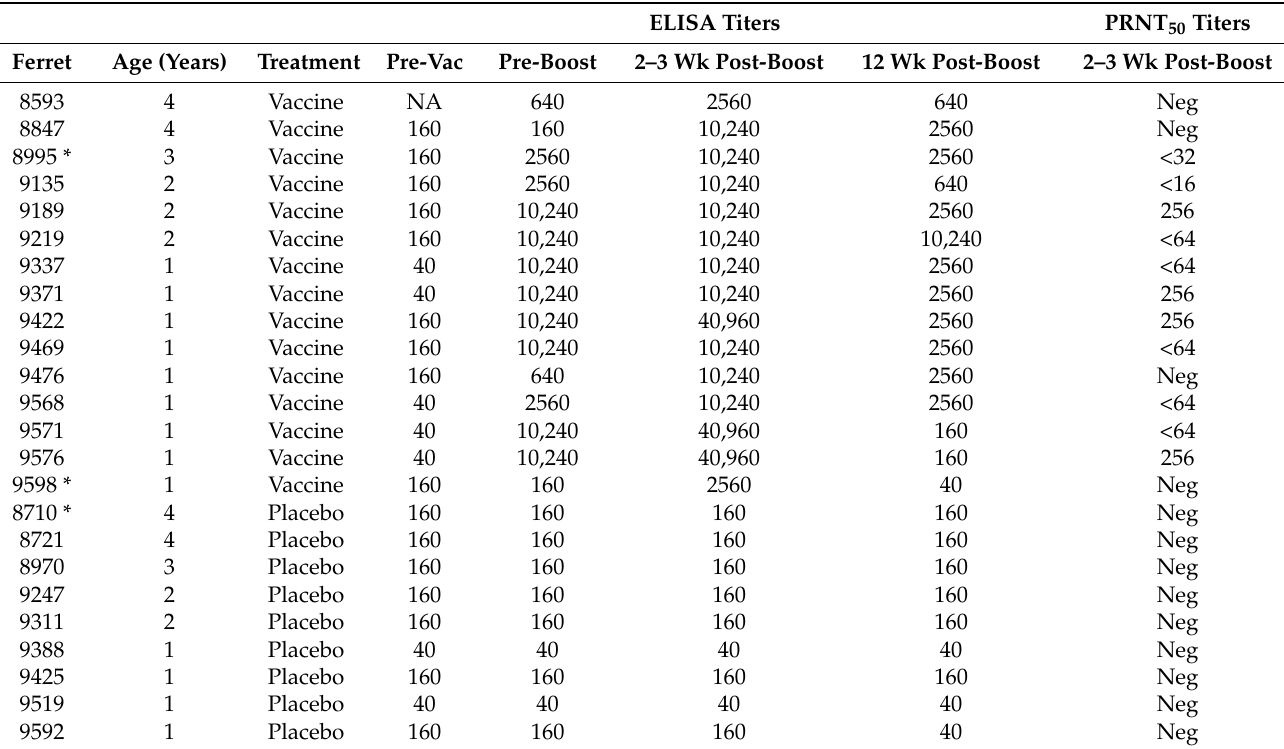
Table 1. Anti-SARS-CoV-2 antibody titers in black-footed ferrets determined by enzyme linked immunosorbent assays (ELISA) and plaque reduction neutralization assays (PRNT 50 ) by treat- ment, age, and time post-vaccination. ELISA titers ≤ 160 are considered background levels and, thus,